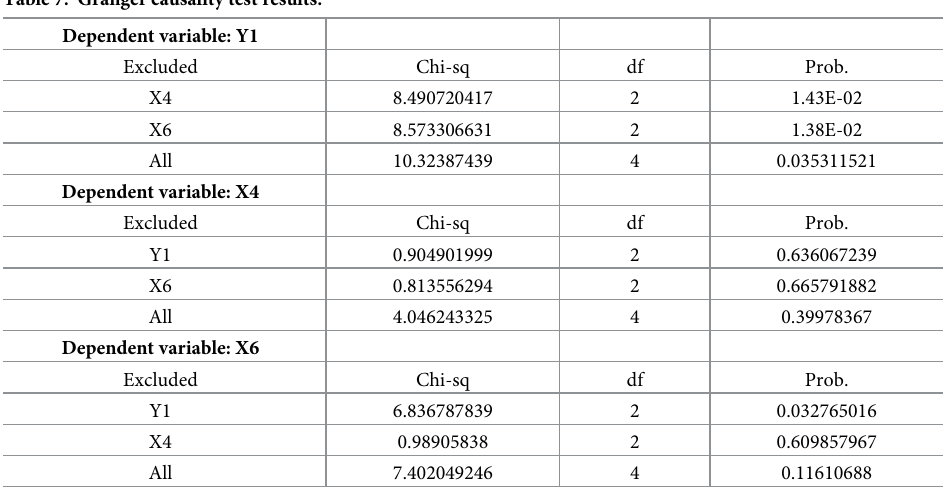
Table 7. Granger causality test